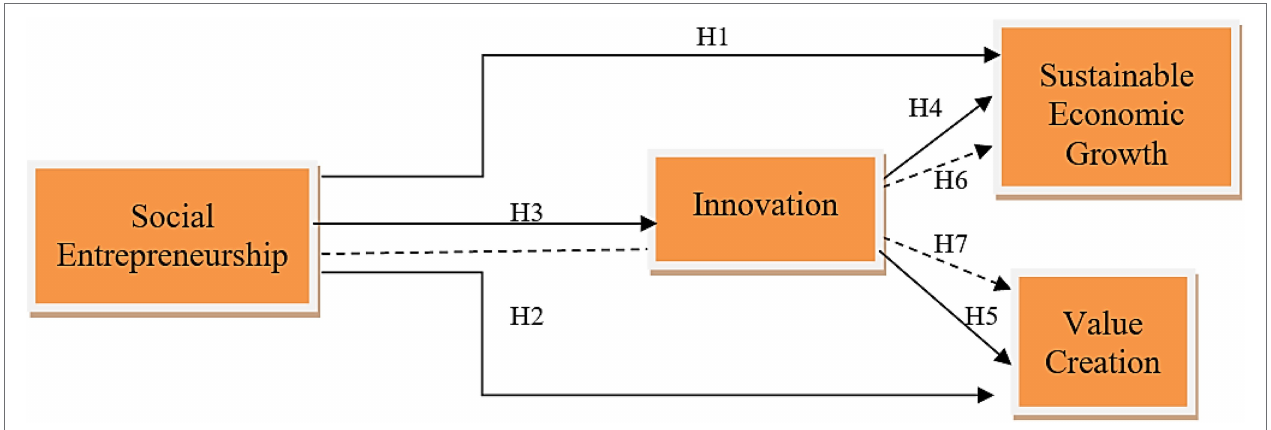
FIGURE 1 | Theoretical framework. SE, social entrepreneurship; inno, innovation; SEG, sustainable economic growth; VC, value